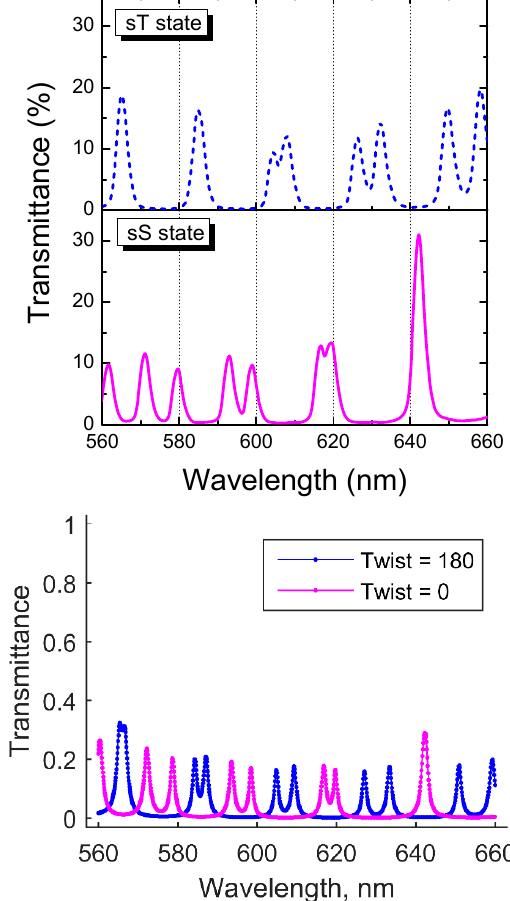
Figure 3. Transmission spectra of the 1D PC/CD-DFLC cell in the memory-mode sS and sT states: Laboratory spectra ( top ); and simulated spectra ( bottom ). Note that the simulated dielectric thicknesses in the multilayers, d SiO2 = 105.8 nm and d Ta2O5 = 71.5 nm, have been acceptably tuned to match the experimental results in accordance with the mirror spectra. The LC layer thickness was set to 4555 nm.